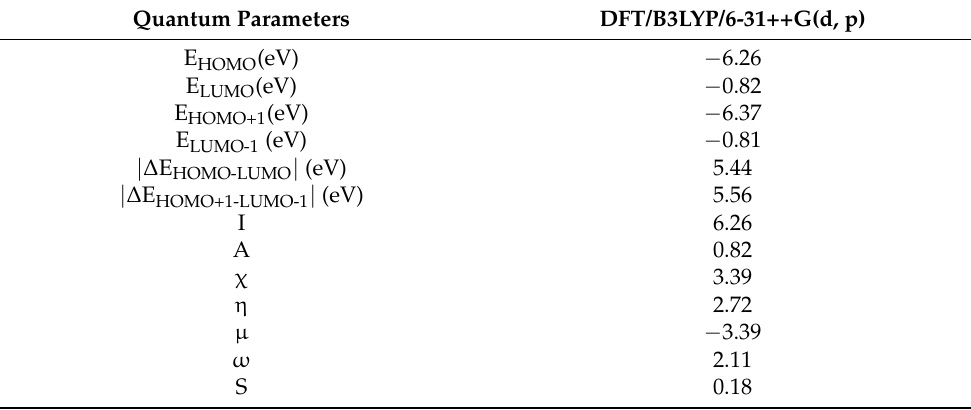
Table 3. HOMO-LUMO energy and other electronic properties of title